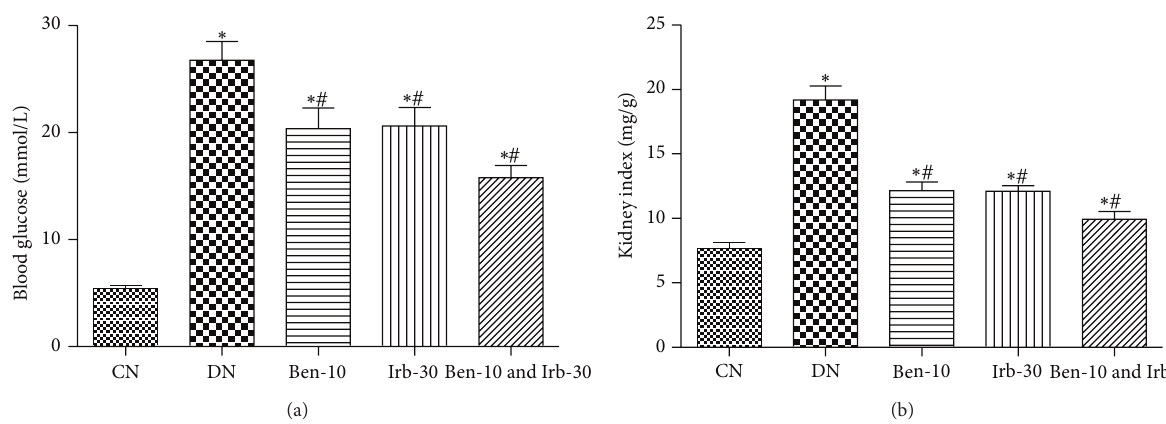
Figure 2: The effect of benazepril and irbesartan on the levels of blood glucose (a) and kidney index (b); CN: normal control group, group 1; DN: diabetic nephropathy control group, group 2; Ben-10, group 3 (benazepril 10mg/kg/d); Irb-30, group 4 (irbesartan 30 mg/kg/d); and Ben-10 and Irb-30, group 5; and compared with group 1, ∗ 𝑃 < 0.05 ; compared with group 2, # 𝑃 < 0.05 .